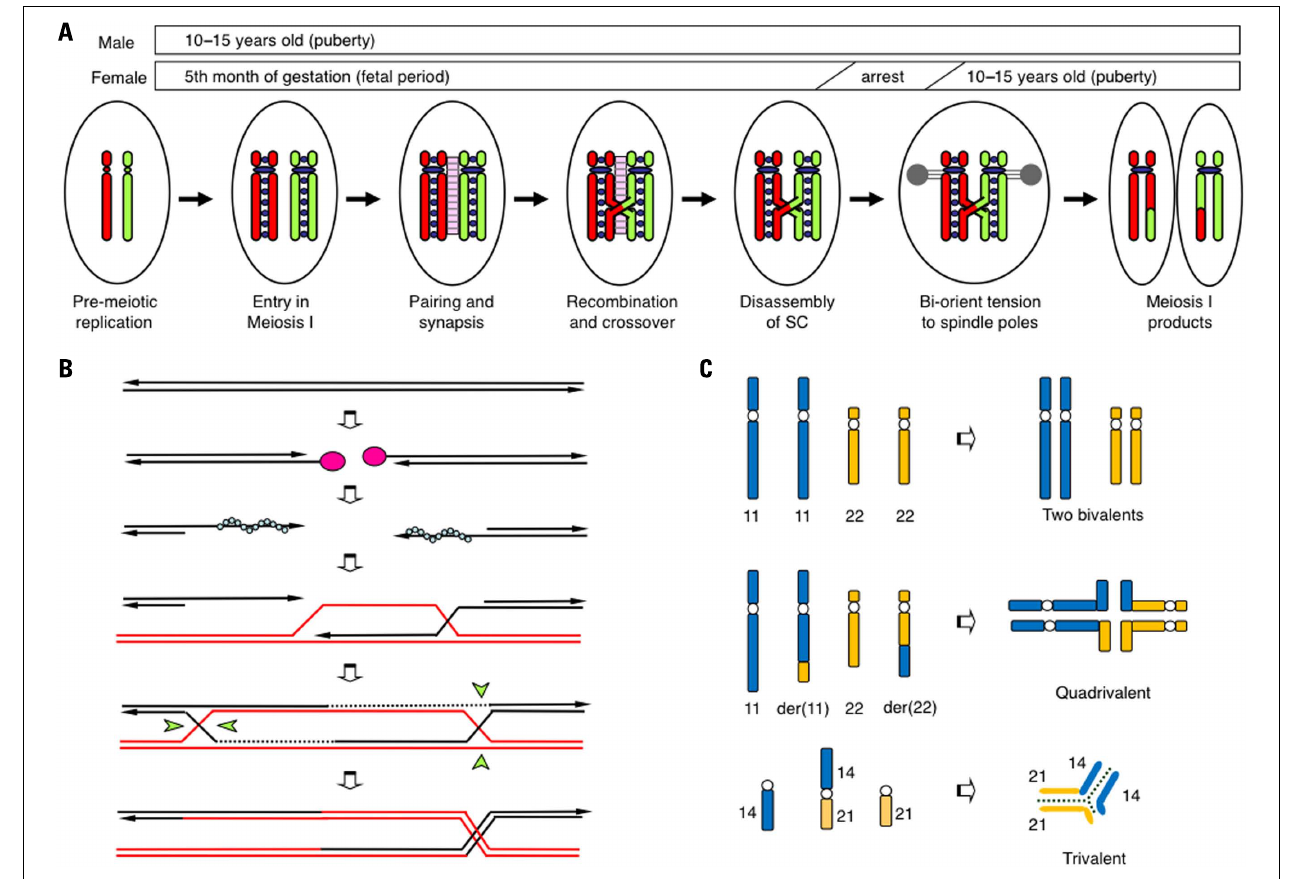
or DMC1, the DNA ends produce nucleofilament complexes (blue circles) that facilitate genome-wide homology scanning in order to find homologous chromosomes (red lines). Next, a single-stranded DNA end invades the homologous duplex DNA, forming a D-loop structure. DNA synthesis seals the DSBs and the double Holliday junctions emerge.These Holliday junctions are resolved in one of two ways, crossover (right) or non-crossover (left), with the Holliday junction resolvase (green wedges). (C) Pachytene configuration in balanced carriers of chromosomal translocation. In t(11;22) reciprocal translocation, two translocated chromosomes in concert with two normal counterparts form a quadrivalent to complete synapsis. In a t(14;21) Robertsonian translocation, the translocated chromosome and the two normal counterparts form a